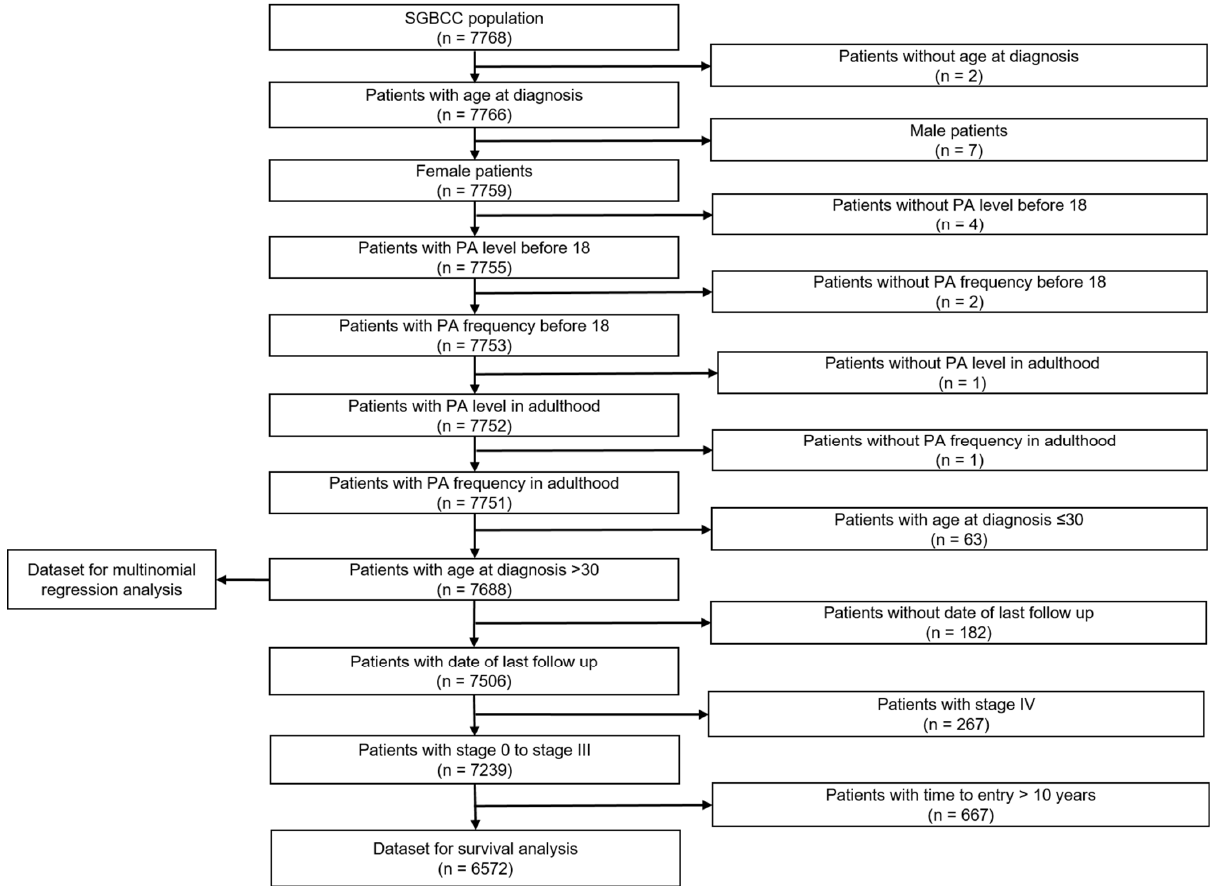
Figure 2. Flow chart of study population. Population comprised of breast cancer patients in the Singapore Breast Cancer Cohort (SGBCC), recruited between 2011 and 2016. Singapore Breast Cancer Cohort (SGBCC), recruited between 2011 and